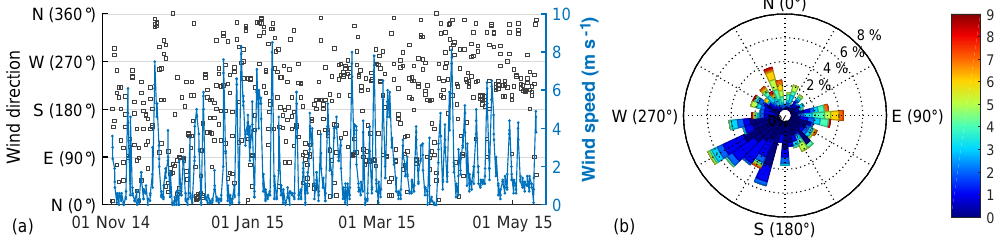
Figure 10. Time series of wind direction and speed hourly data at the 3h interval (10:00–13:00UTC) around the OMI overpass time during the campaign period (a) and the corresponding wind rose diagram (b)